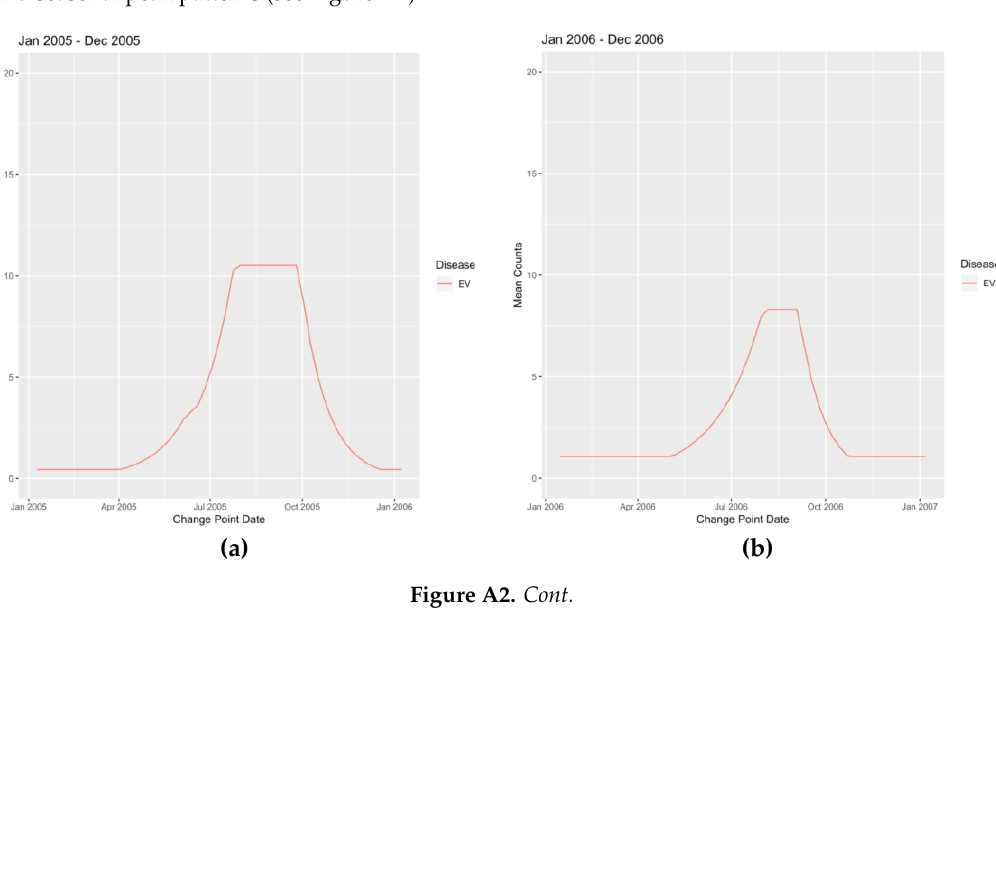
Figure A1. Five virus change point plots: mean count of monthly timing of positive viral samples for influenza A (INFLA), influenza B (INFLB), respiratory syncytial virus (RSV), human metapneumovirus (HMPV), and rhinovirus (RHINO) from mid-2004 ( a ) to late-2017 ( m ), in the Intermountain Health Care system. Note that November 2006 was the first month data were available for HMPV, and November 2007 was the first month data were available for RHINO, so respective viral data are provided starting after given dates. Enterovirus (EV) is plotted separately due to significant difference in mean counts and seasonal peak patterns (see Figure A2).